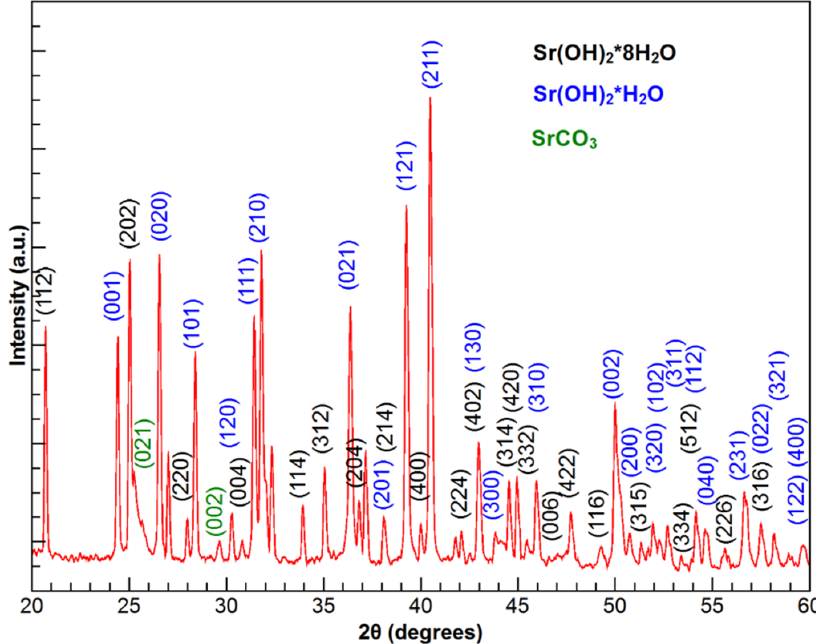
Figure 5. The X ‐ ray diffraction (XRD) pattern obtained for the SrCO 3 ‐ Sr(OH) 2 nanocomposite.